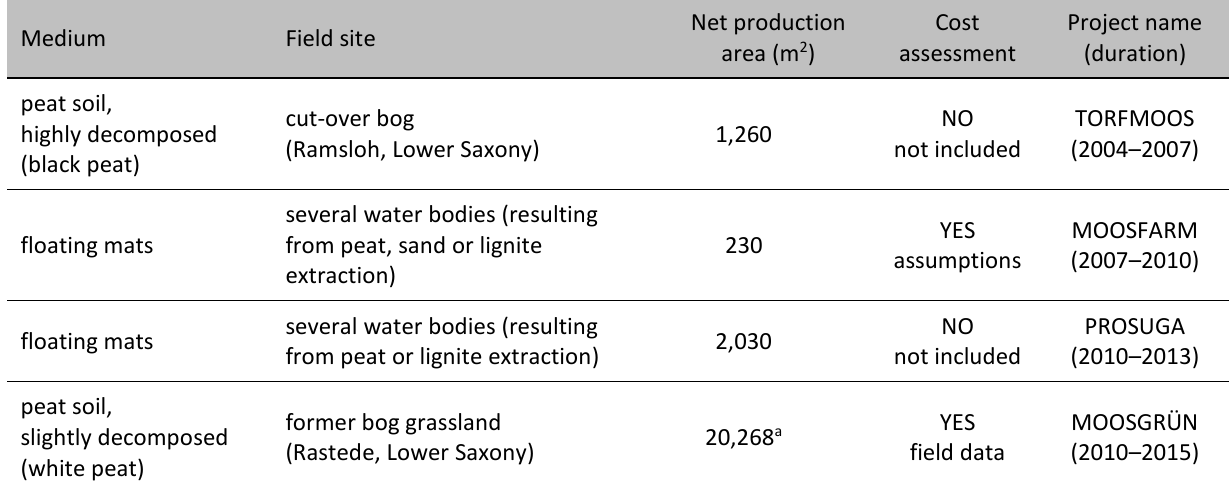
Table 1. Main features of Sphagnum culture pilot trials conducted within four German research projects